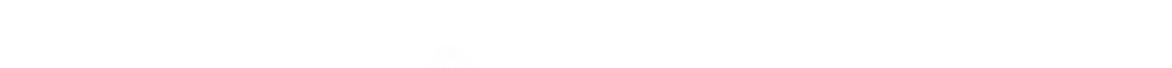
Table 3 Descriptive statistics of stressor intensity and frequency items: professional and enrolled